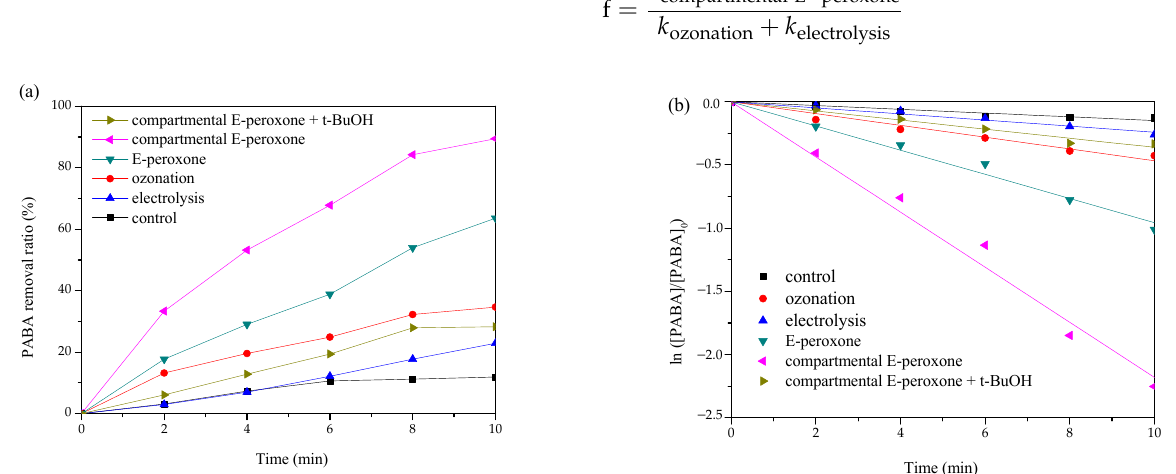
Figure 2. Comparison of PABA degradation in various oxidation processes: ( a ) removal ratio and ( b ) the pseudo first-order reaction kinetics (Initial PABA concentration = ~10 mg/L; Gas flow rate = 0.2 L/min; Inlet O 3 concentration = ~20 mg/L; Applied current = 20 mA/cm 2 ; Initial solution pH = 6.9; Temperature = 25 ± 2 °C).